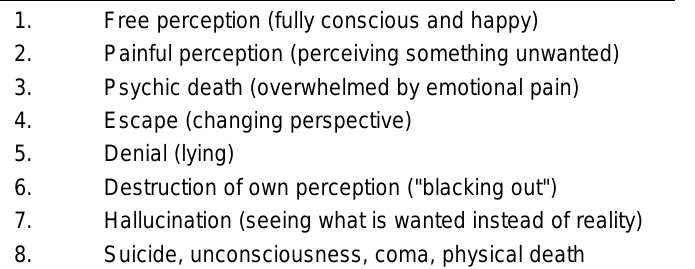
Pathogenesis of Mental Diseases Seen as an